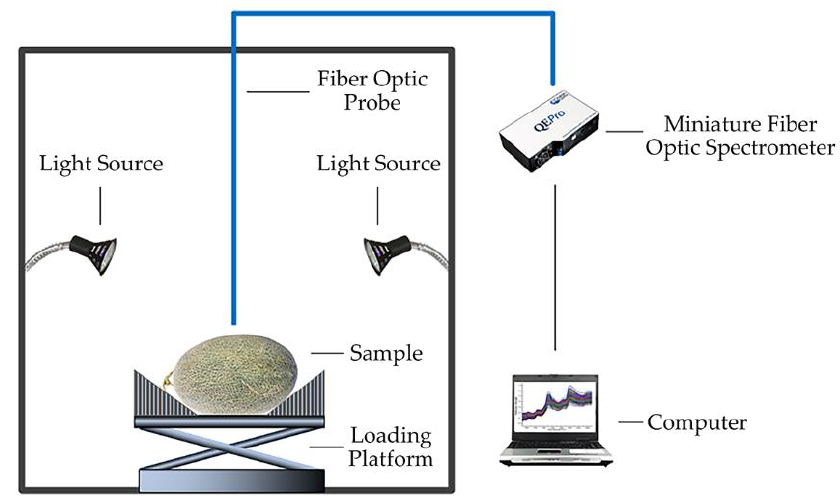
Figure 2. Vis/NIR spectral data acquisition system. Note: Cited from Yu et al. [23].